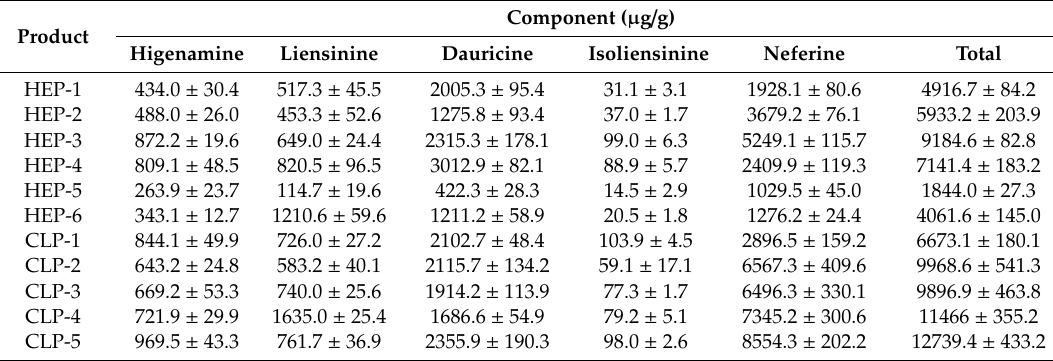
Figure 1. The high-performance liquid chromatography with a diode-array detector (HPLC-DAD) chromatograms of ( A ) the mixed standard solution and ( B ) lotus plumule concentrated powder using microwave-assisted extraction with 20 time dilution. 1: Higenamine; 2: Liensinine; 3: Dauricine; 4: Isoliensinine; 5: Neferine; 6: Nuciferine. Table 6. Alkaloid contents of lotus plumule products.